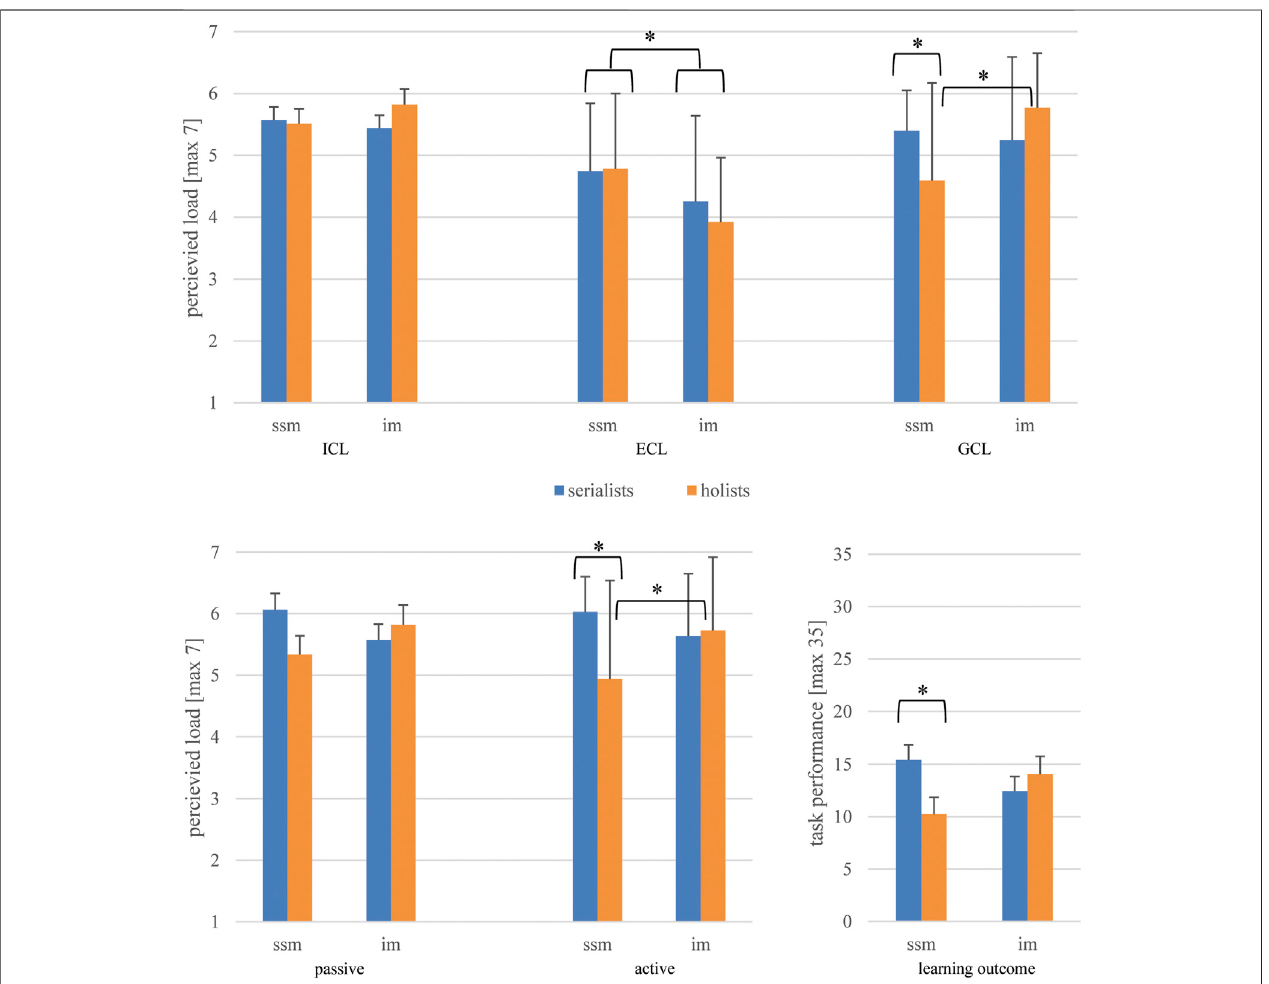
FIGURE 2 | Effects on the dependent variables for study 2. Note: ssm (cid:1) split-source material, im (cid:1) integrated material; * (simple) main effect with p ≤ 0.05.